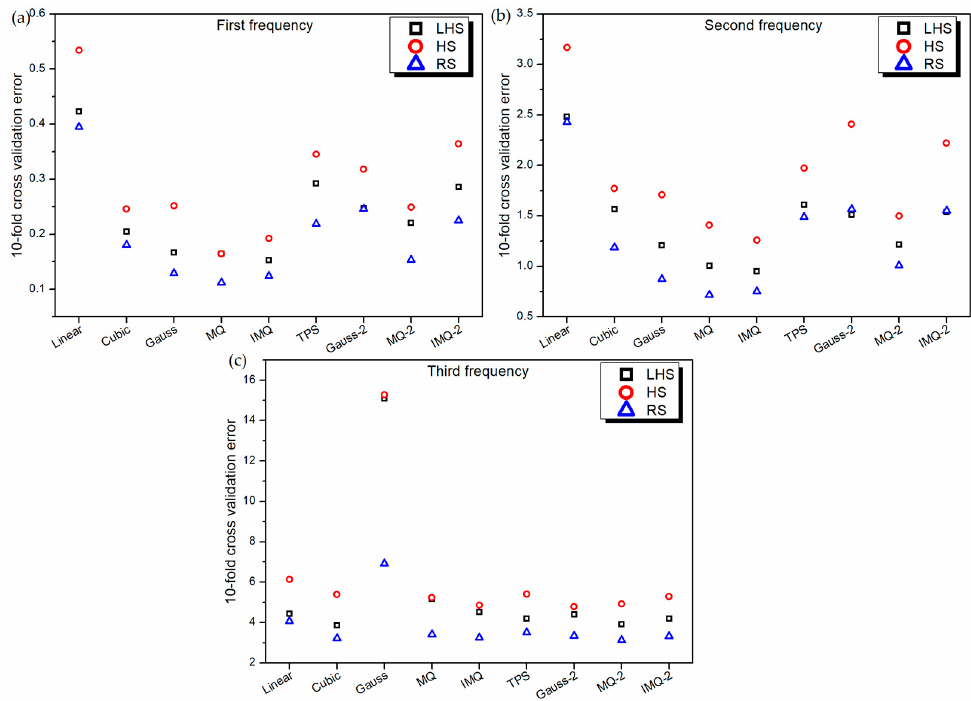
Figure 2. 10-fold cross-validation error of various RBF metamodels in LD